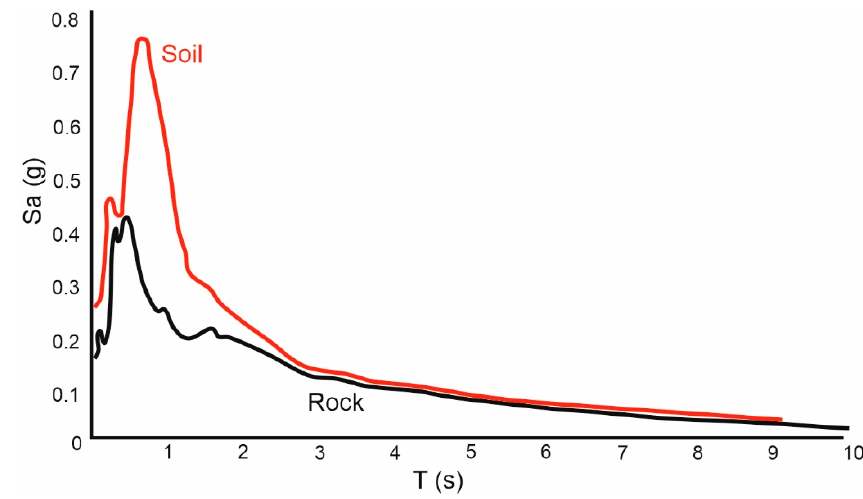
Figure 8. Rock and coluvial strata surface response spectrum for the BH-03